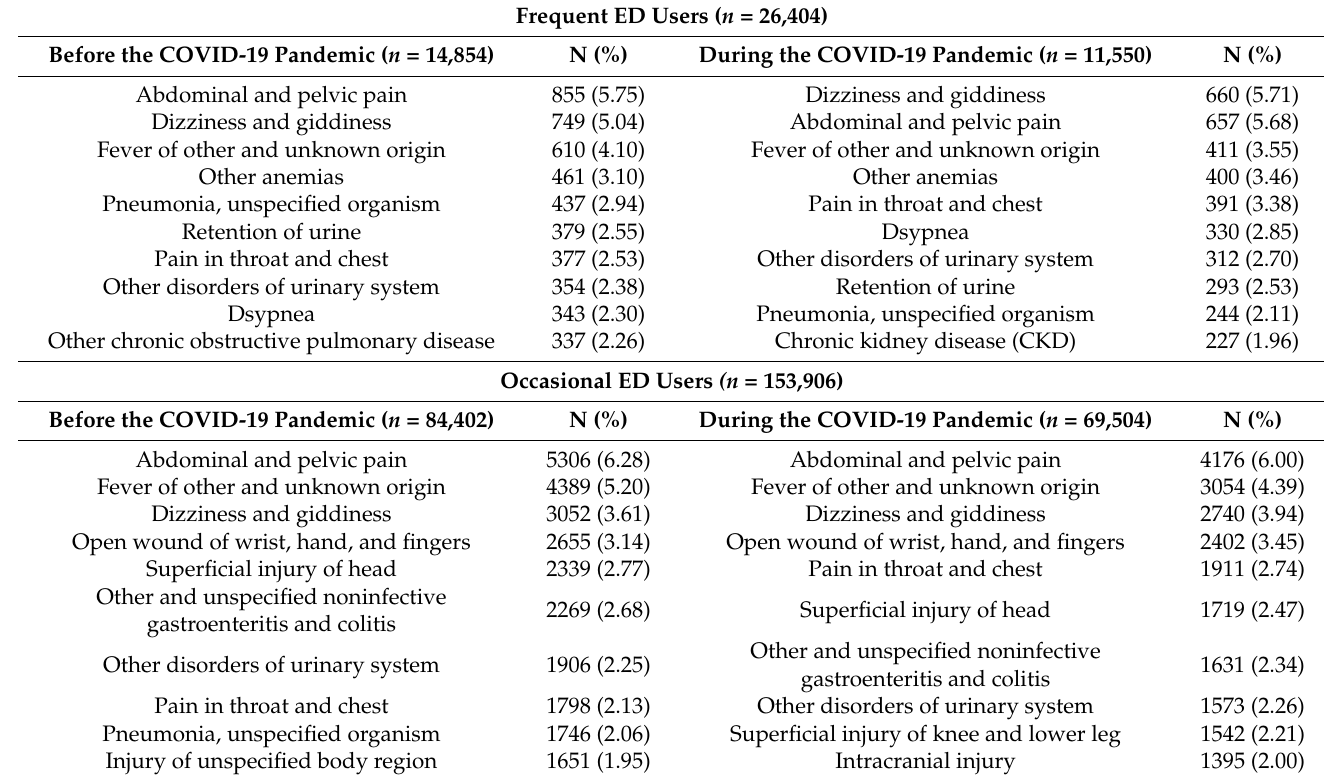
Table A1. The ten most frequent primary diagnoses among frequent and occasional ED users before (February 2019–January 2020) and during the COVID-19 pandemic (February 2020–January 2021) ( n =